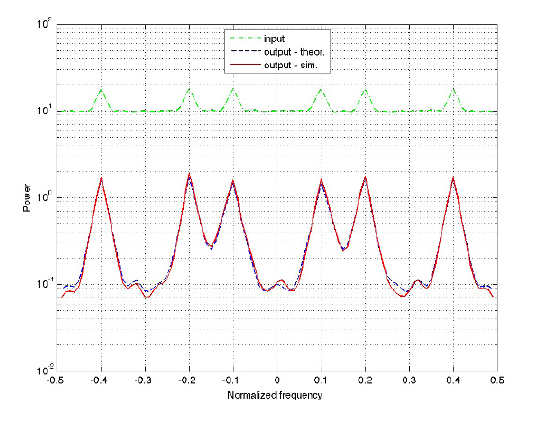
Figure 8. Line enhancer output signal spectrum.